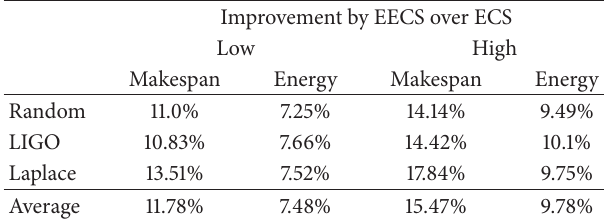
Table 8: Comparative results of different heterogeneities of proces-